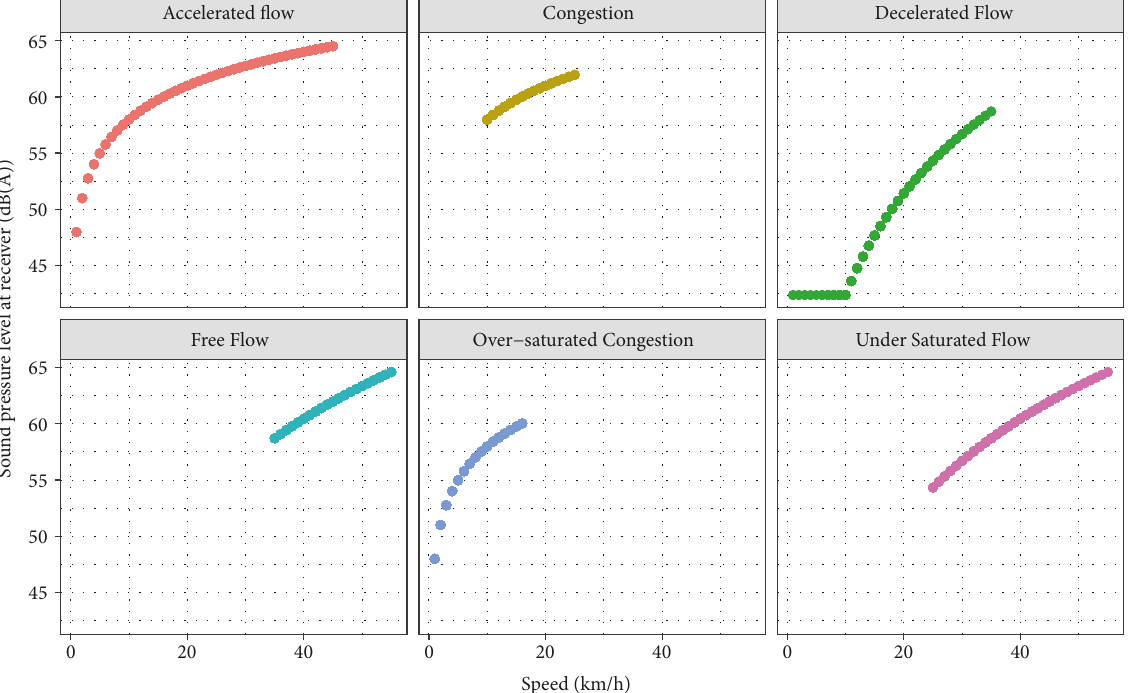
Figure 4: Theoretical relationship between speed ranges and the generated sound pressure in different traffic conditions.